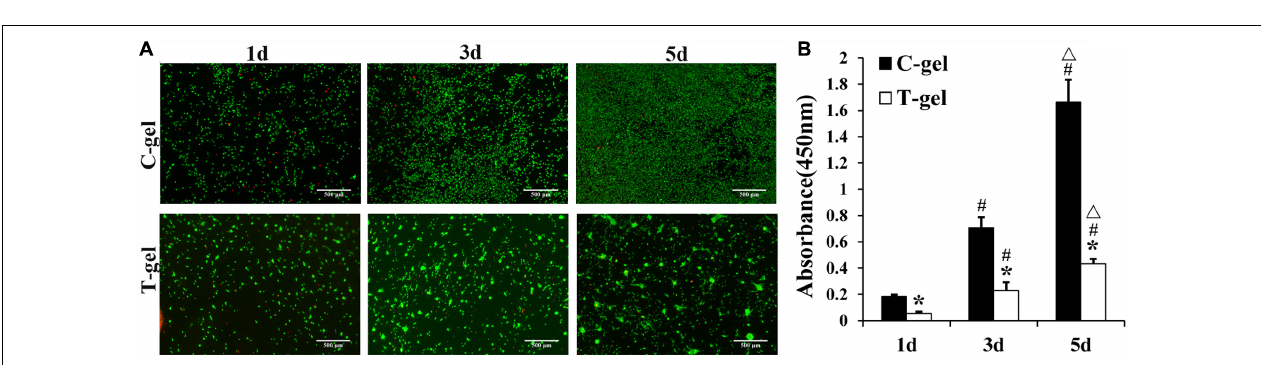
FIGURE 5 | Cytotoxicity analysis of the C-gel and T-gel. (A) Live/Dead staining of NIH 3T3 fibroblasts seeded on the C-gel and T-gel at 1, 3, and 5 days by fluorescence microscopy (green, live cells; red, dead cells). Scale bar = 500 µ m. (B) The cytotoxicity of the C-gel and T-gel using NIH-3T3 fibroblasts cultured for 1, 3, and 5 days as determined by the CCK-8 assay. *Signifies a P- value of < 0.05 as compared to the C-gel; #, signifies a P -value of < 0.05 as compared to 1 day for each gel; (cid:77) , signifies a P -value of < 0.05 as compared to 3 days for each